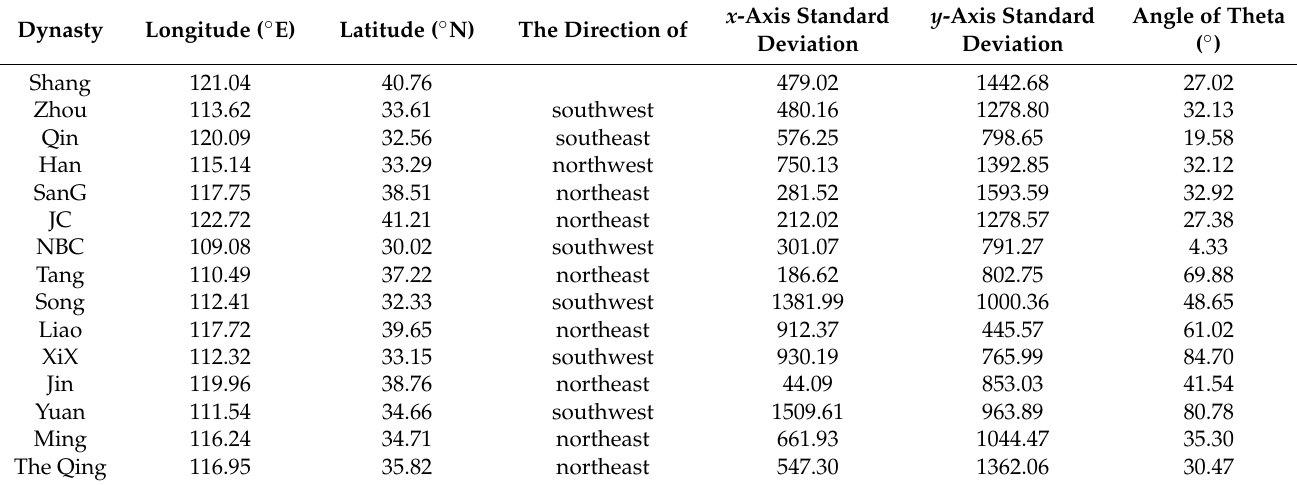
Table 3. The evolution of the center of gravity of the weapon spatial distribution and the standard deviation ellipse parameters.